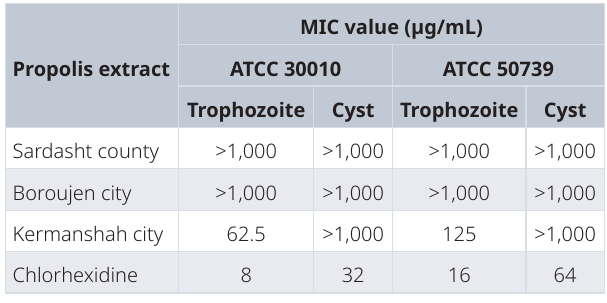
Table 1. MIC determination of Propolis extracts and antibiotic against Acanthamoeba castellanii .